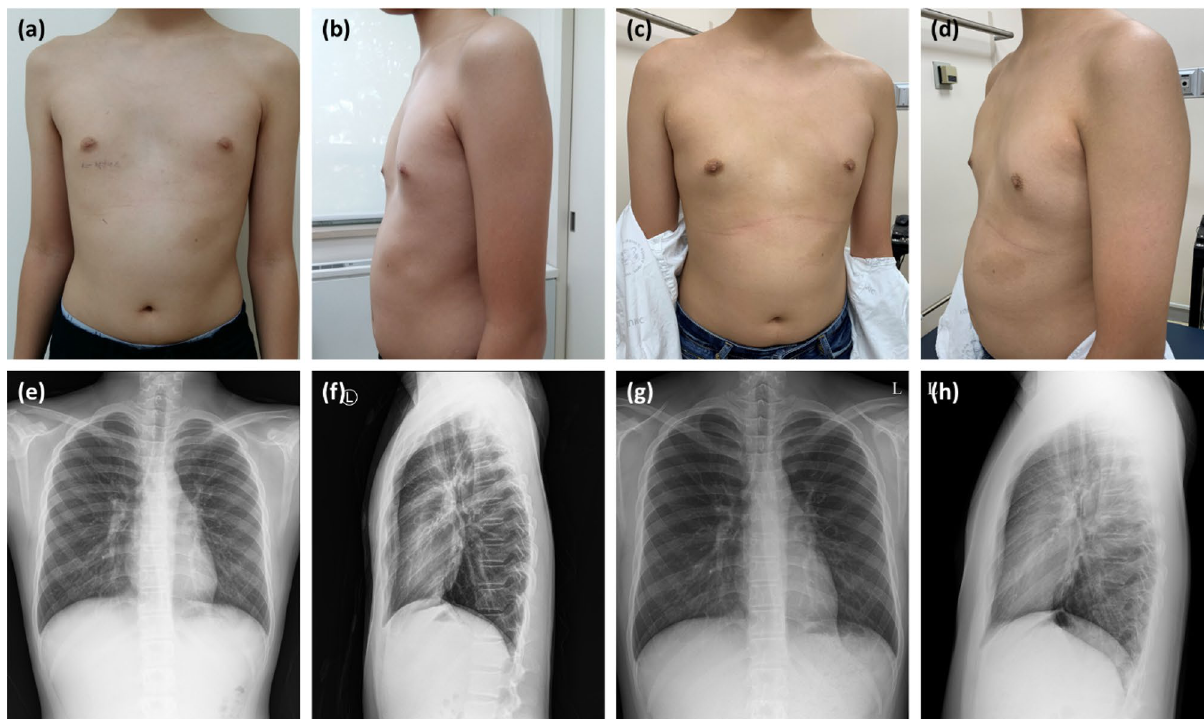
Figure 3. Evaluation of treatment outcomes after 1 year of vacuum bell (VB) application. Pictures and chest radiographs were taken from a 17-year-old male patient just before starting treatment ( a , b , e , f ) and at 1 year after VB therapy ( c , d , g , and h ). ( a ) Anterior view before VB application; ( b ) lateral view before VB application; ( c ) anterior view at 1 year after treatment; ( d ) lateral view at 1 year after treatment; ( e ) anteroposterior view on chest radiographs taken before starting therapy; ( f ) lateral view before starting therapy; ( g ) anterolateral view after 1 year of treatment; and ( h ) Lateral view after 1 year of